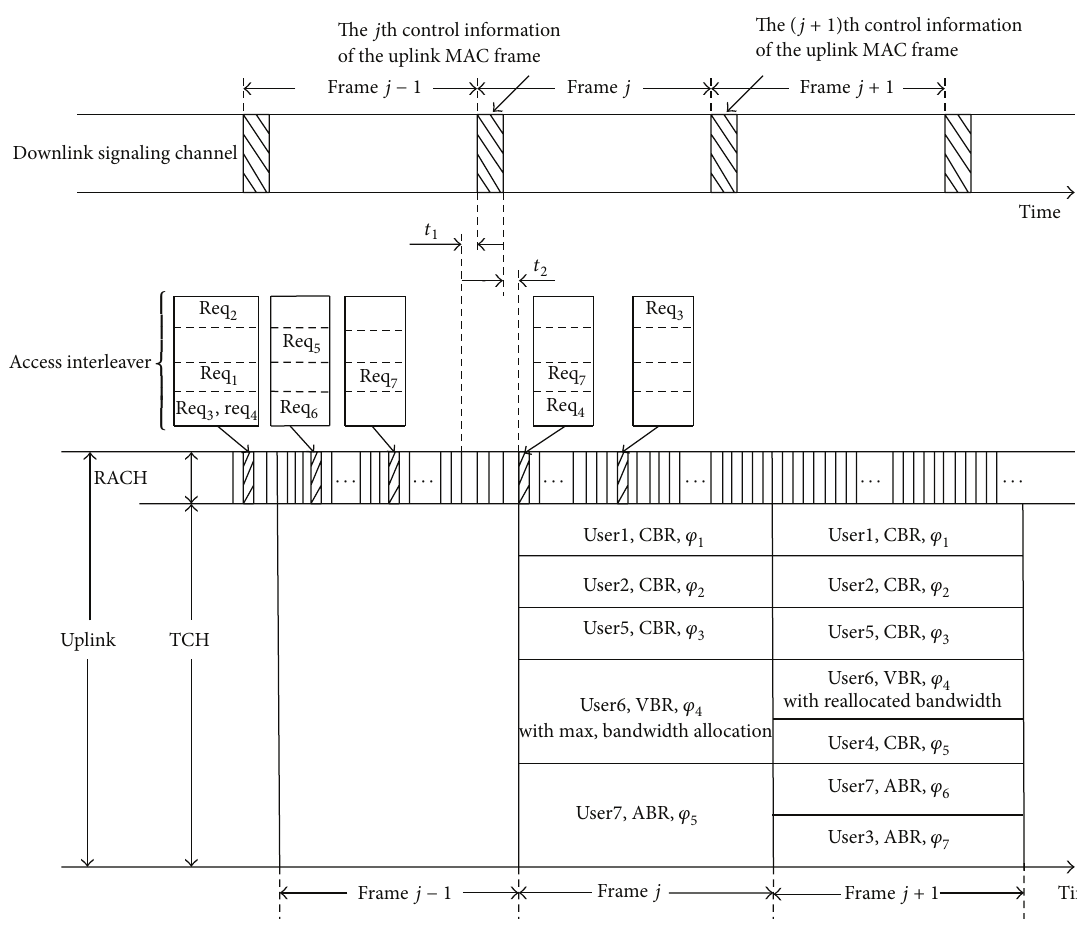
Figure 1: MAC protocol of